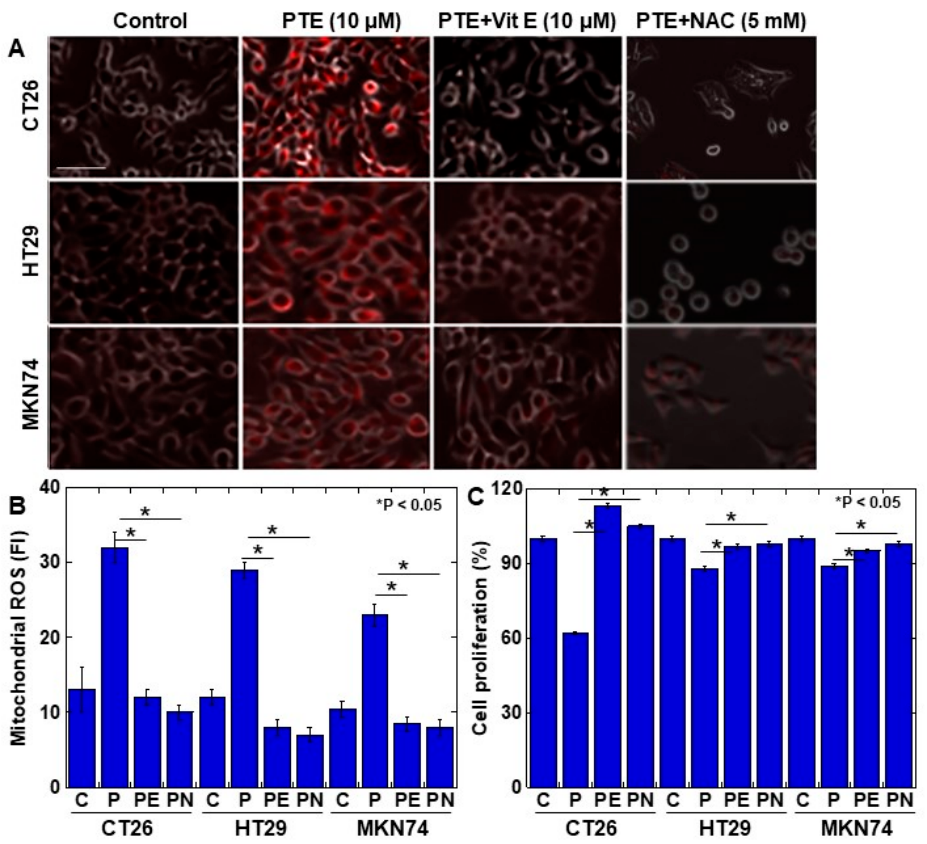
Figure 5. Effect of vitamin E on PTE-induced oxidative stress in cancer cell lines. Cells were treated with or without PTE (10 μ M) and/or vitamin E (10 μ M) and/or N-acetyl-L-cysteine (NAC) (5 mM) for 48 h. ( A ) Mitochondrial ROS was assessed by MitoROS (red color). MitoROS image was merged with phase-contrasted image. ( B ) Cell proliferation was assessed by MTS. ( C ) Semi-quantification of mitochondrial ROS. C, control; P, PTE; PE, PTE+vitamin E; PN, PTE+NAC. Error bar, standard deviation from three independent examinations. Statistical difference was calculated by ordinary analysis of variance. Scale bar, 25 μ m. PTE, pterostilbene; ROS, reactive oxidative species; FI, fluorescence intensity; NAC, N-acetyl-L-cysteine; MTS, 3-(4,5-dimethylthiazol-2-yl)-5-(3- carboxymethoxyphenyl)-2-(4-sulfophenyl)-2H-tetrazolium.